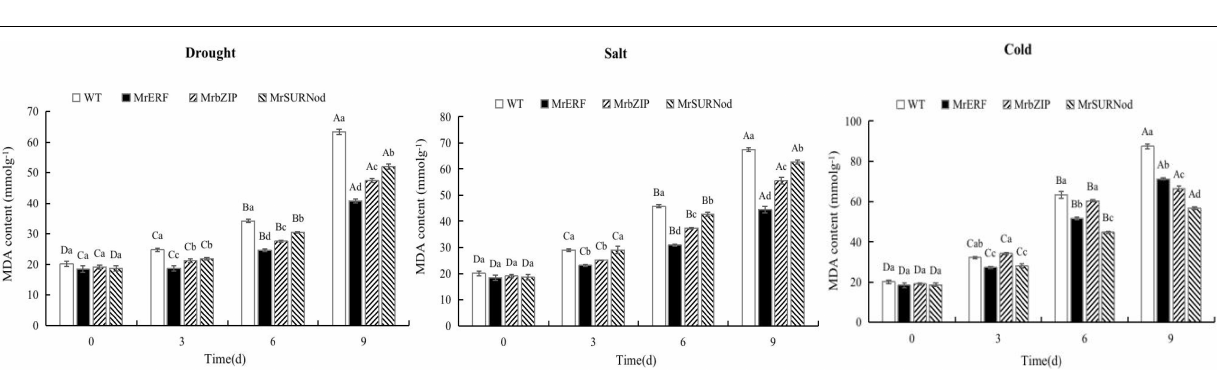
FIGURE 11 | Effects of different stresses on MDA content of tobacco. Different capital letters indicate significant differences under different treatments, and different lowercase letters indicate significant differences among different transgenic lines in the same treatment ( P <